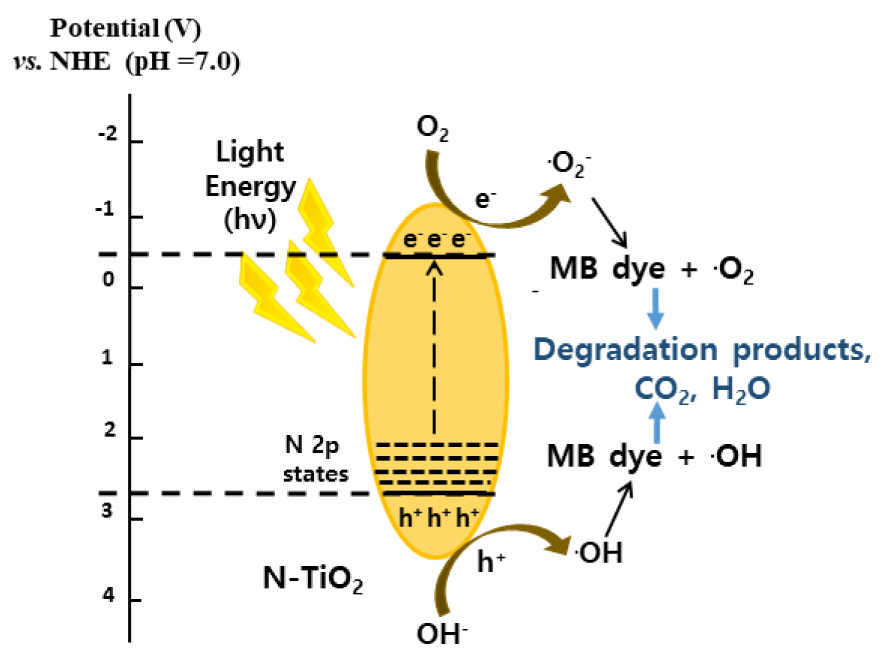
Figure 11. Mechanistic overview for photocatalytic degradation of MB dye simulated wastewater by NT